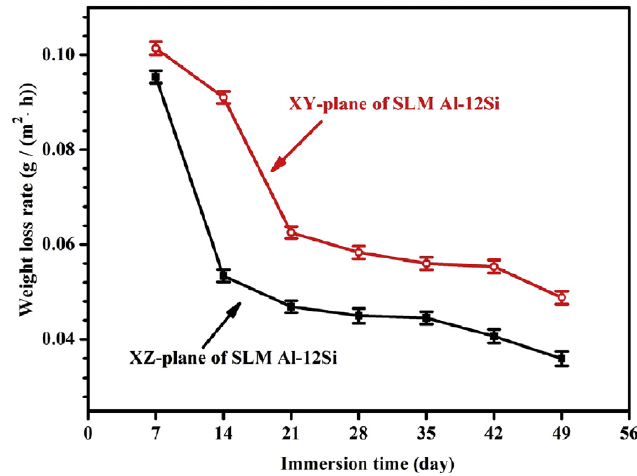
Figure 7. The weight loss rate for the different surface planes (parallel to the building platform—XY—and perpendicular to the building platform—XZ) of as-built and mechanically polished SLM AlSi12 after immersion in 3.5 wt.% NaCl solution at room temperature [42].